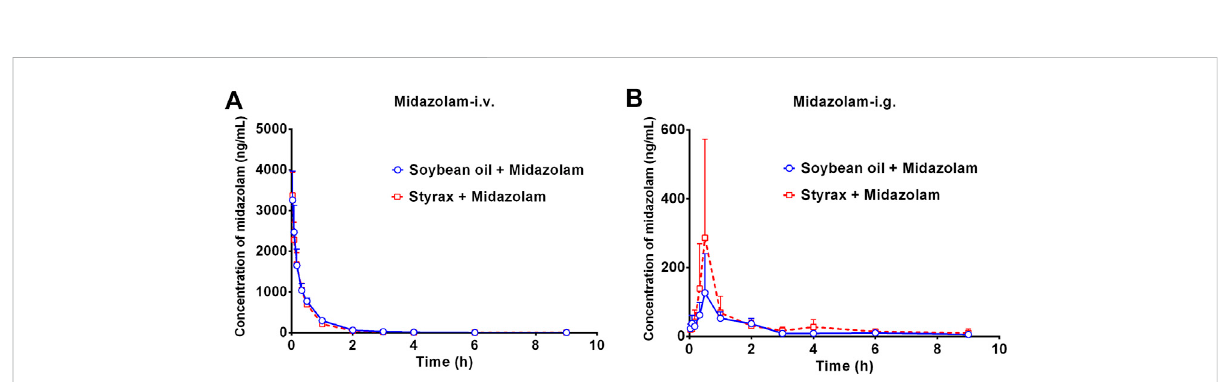
FIGURE 3 (A) The mean plasma concentration-time curves of midazolam after intravenous administration of midazolam (5 mg/kg) in rats pretreated with Soybean oil (blue) or Styrax (i.g. 100 mg/kg, red). (B) The mean plasma concentration-time curves of midazolam after intragastric administration